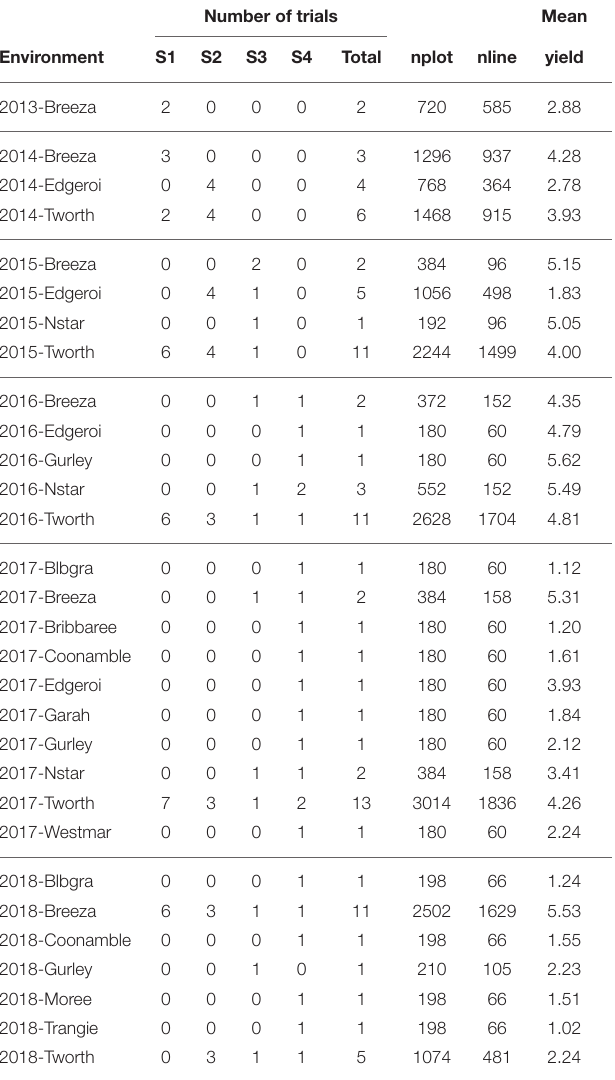
TABLE 7 | Summary of environments in the durum MET dataset: number of trials for each stage of testing (S1, S2, S3, S4) and total number of trials. Number of trials Mean Environment yield